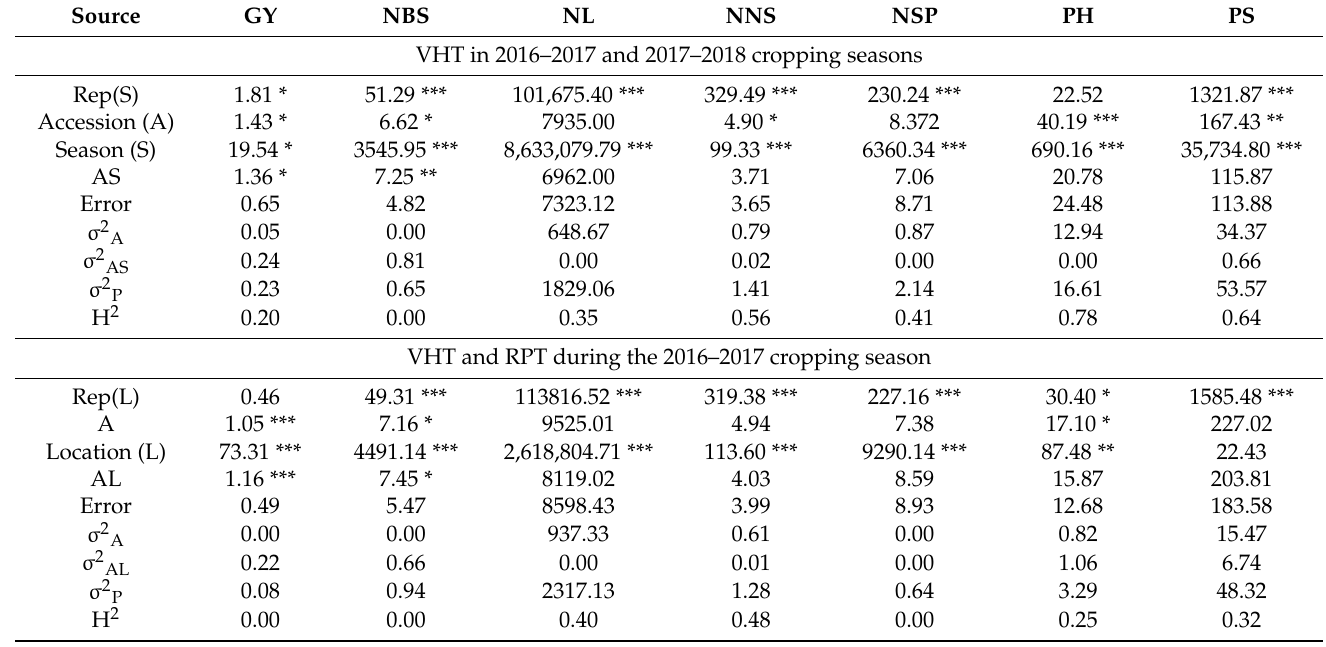
Table 2. Mean squares, variance components ( σ 2 ) and broad-sense heritability (H 2 ) for grain yield and yield components for Vaalharts (VHT) and Roodeplaat (RPT) for 2016–2017 and